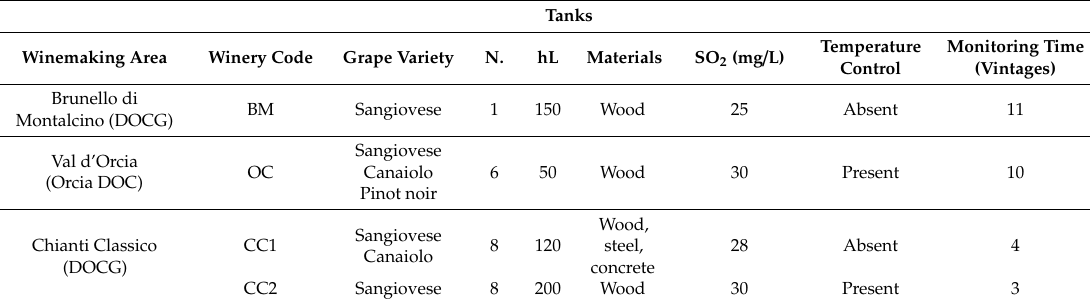
Table 1. The locations and main characteristics of the Tuscany wineries under study, along with observation